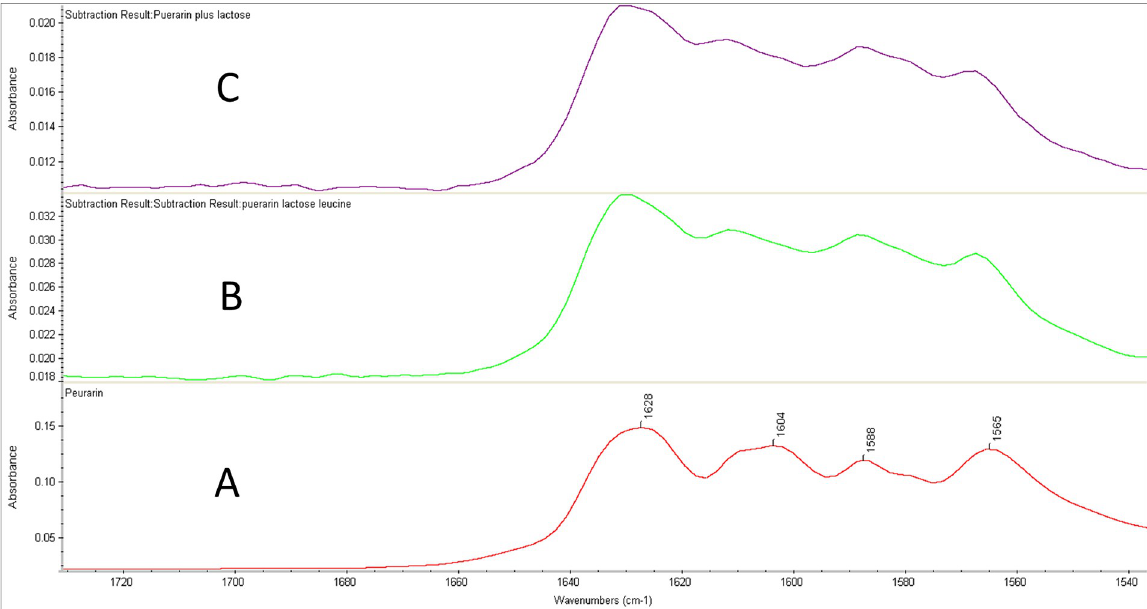
Fig 5. ATR-FTIR of puerarin (pure) and puerarin subtracted from the mixtures. A. Pure puerarin, B. puerarin spectra subtracted from the mixture of lactose and leucine, C. Puerarin spectra subtracted from the mixture of puerarin and lactose.